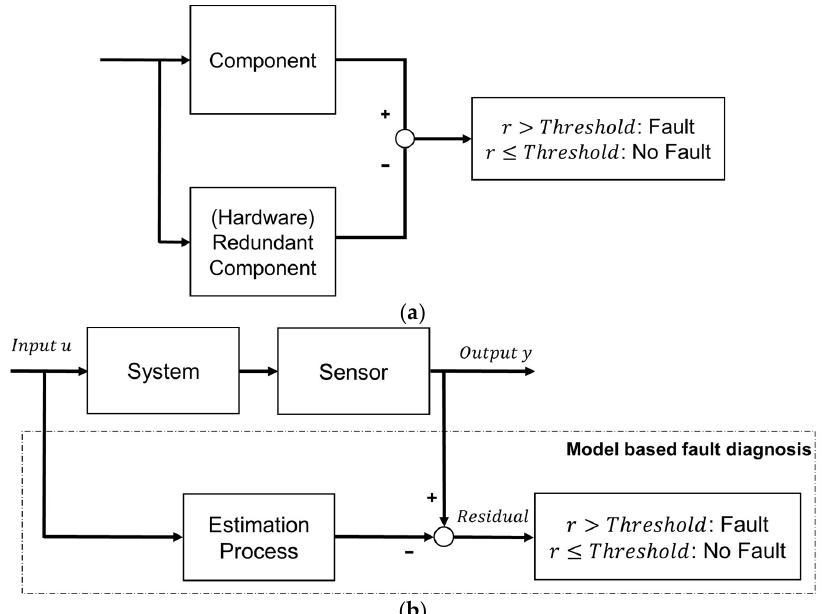
Figure 1. Hardware and analytical redundancy scheme. ( a ) Hardware redundancy scheme; ( b ) analytical redundancy scheme.